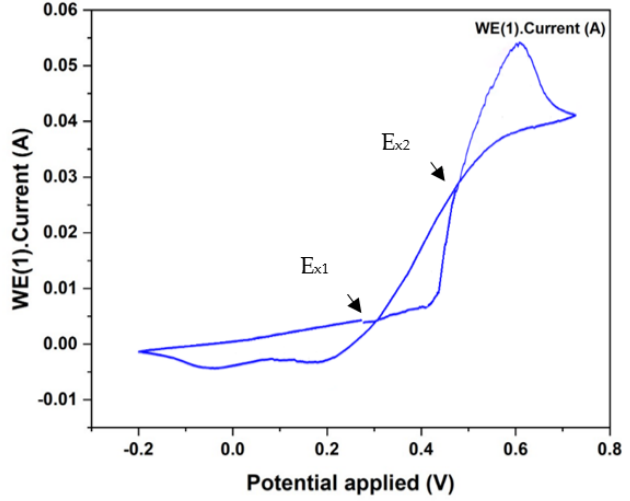
Figure 5. Biochar CV (5 mV/s) in iron hexacyanoferrate (III) 0.02M, 0.1 M KCl. The arrows indicate the two crossing points (Ex 1 and Ex 2 ).